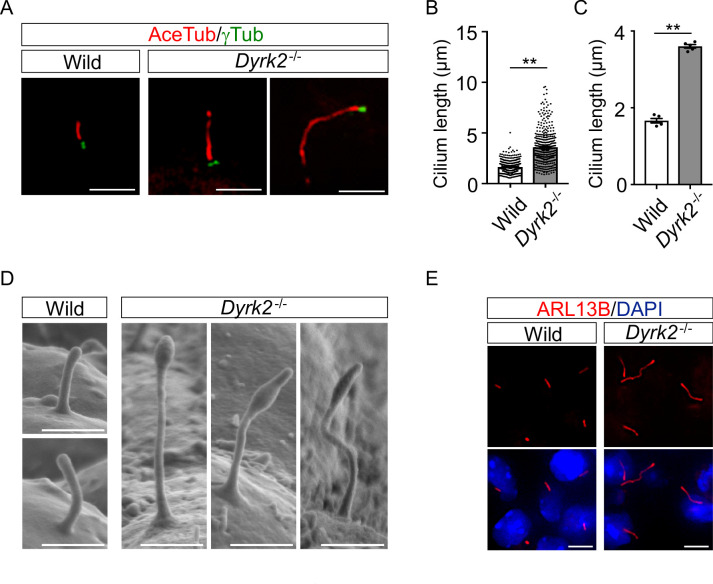
DYRK2 constrains the length of primary cilia.(A–C) Elongation of primary cilia in Dyrk2-/- MEFs. Primary cilia of wild-type and Dyrk2-/- MEFs were immunostained with acetylated-tubulin and gamma-tubulin antibodies. (B, C) Measurements of cilia length in wild-type and Dyrk2-/- MEFs using acetylated-tubulin as a cilia axoneme marker. Cilia lengths are presented as pooled from five MEFs derived from independent embryos of each genotype (B) and the average of each MEF (C). Data are presented as the means ± SEM (n = 5 biological replicates per condition). The statistical significance between wild-type and Dyrk2-/- was determined by the Student’s t-test. (**) p<0.01. (D) Scanning electron microscopy showing wild-type and Dyrk2-/- embryos in the frontonasal prominence at E10.5. (E) Immunohistochemistry of primary cilia in wild-type and Dyrk2-/- embryos. ARL13B was immuno-stained in wild-type and Dyrk2-/- mesenchymal cells at the craniofacial region at E13.5. Nuclei were stained with DAPI. Scale bars, 5 µm (A and E) and 1 µm (D).Figure 4—source data 1.Source data for Figure 4B–C.